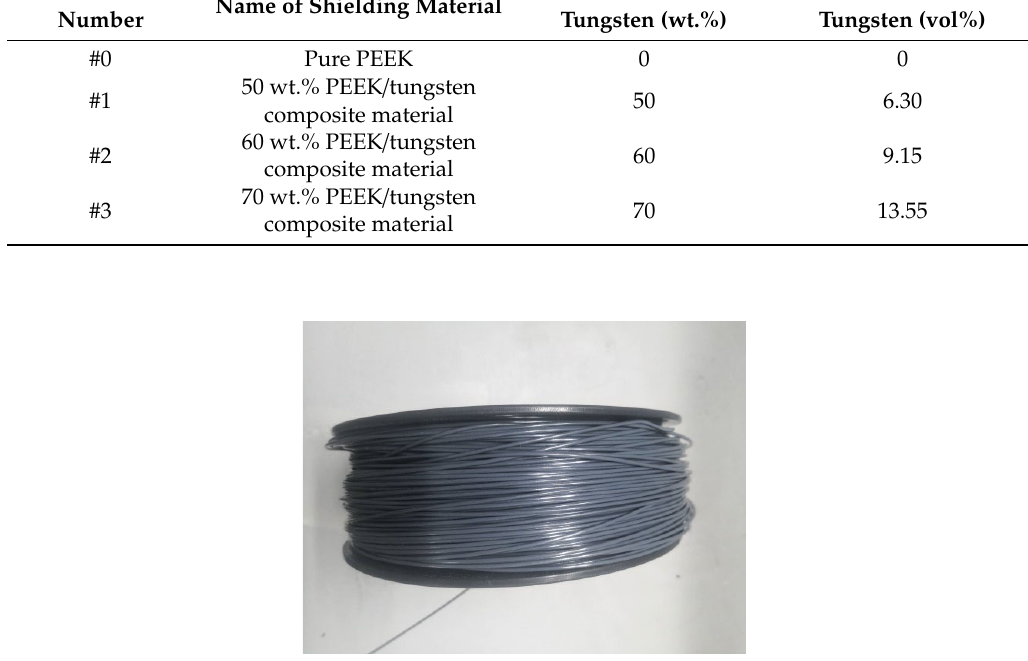
Table 2. The compactness values of PEEK and PEEK